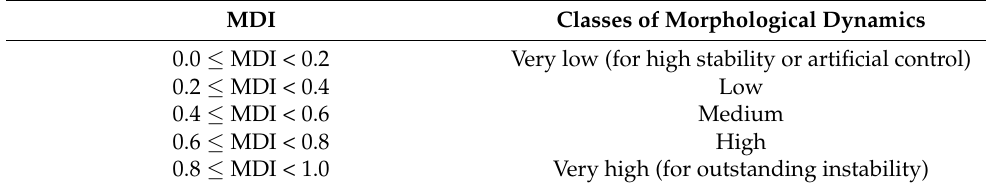
Table 5. MDI values and corresponding classes.